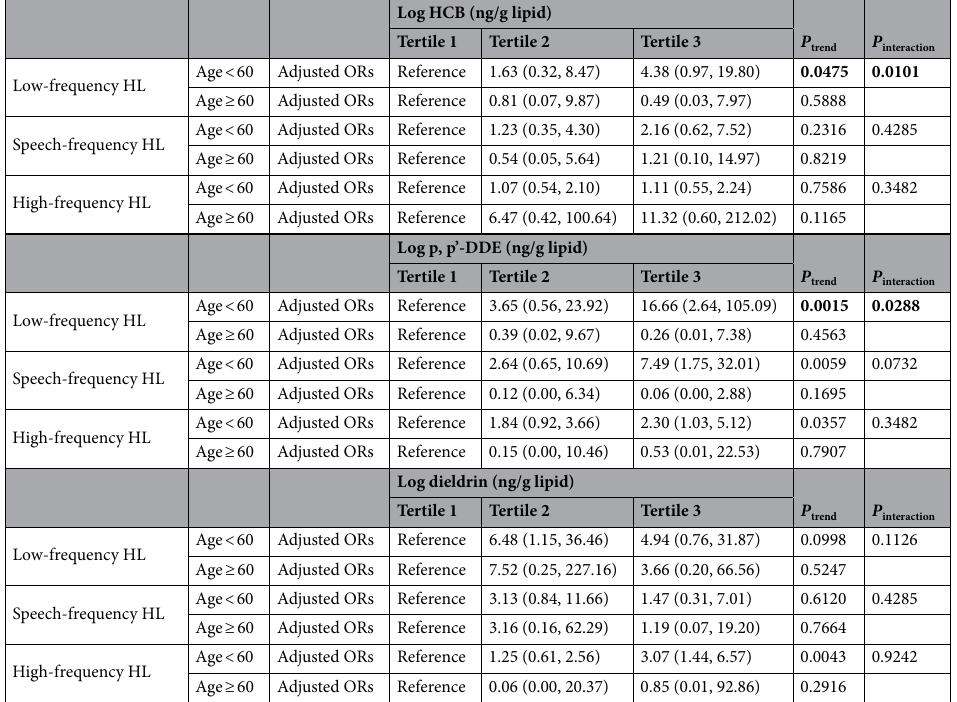
Table 4. Adjusted associations between OCPs and HL stratified by age (N = 366): age < 60 group (N = 308) and age ≥ 60 group (N = 58). Adjusted for gender, race, education level, BMI, diabetes, hypertension, serum cotinine, firearm noise exposure and loud noise/music exposure. OCPs organochlorine pesticides, HCB hexachlorobenzene, p, p’-DDE p, p’-dichlorodiphenyldichloroethylene, BMI body mass index, PTA pure-tone average, HL hearing loss. Significant values are in